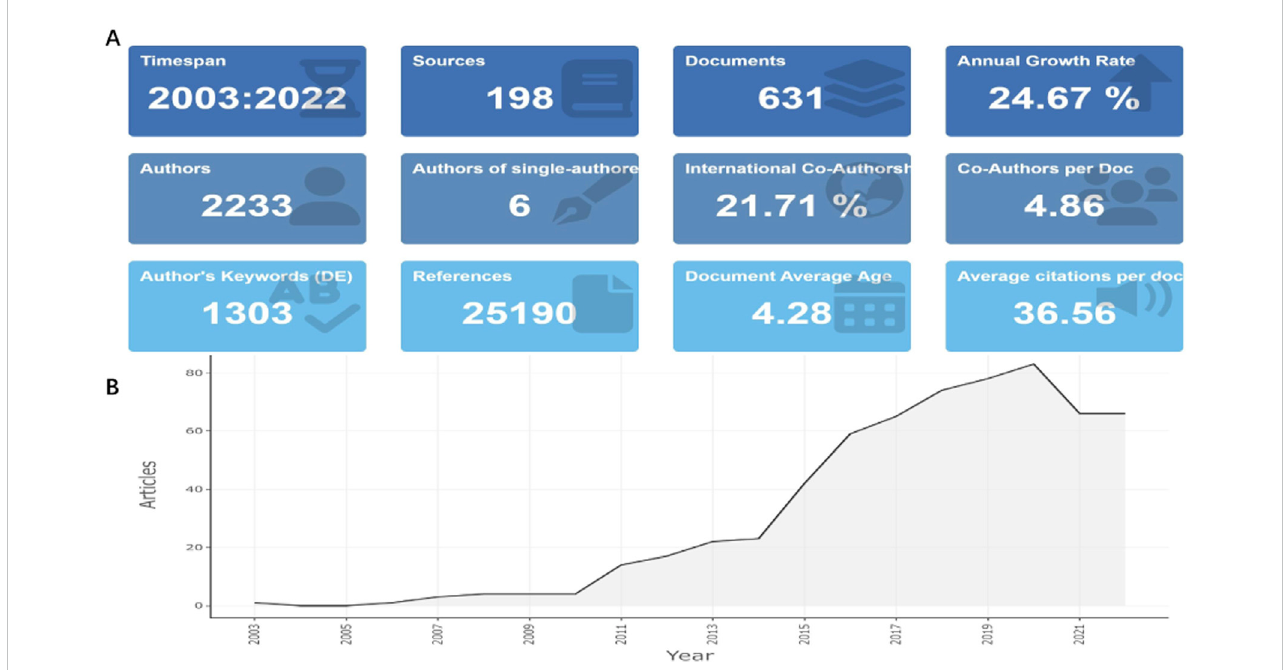
FIGURE 1 Main information (A) and annual scienti fi c production (B) of publications concerning the applications of NHs for drug